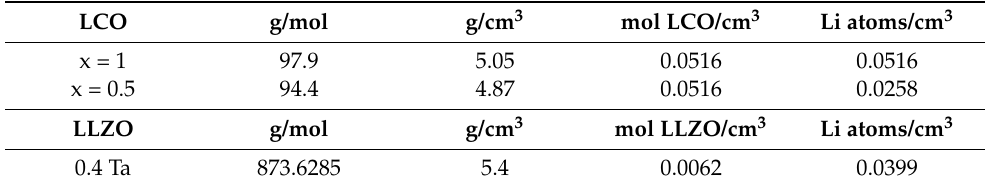
Table A1. Calculation of Li atoms/cm 3 for LLZO and LCO at x = 0 and x = 1.